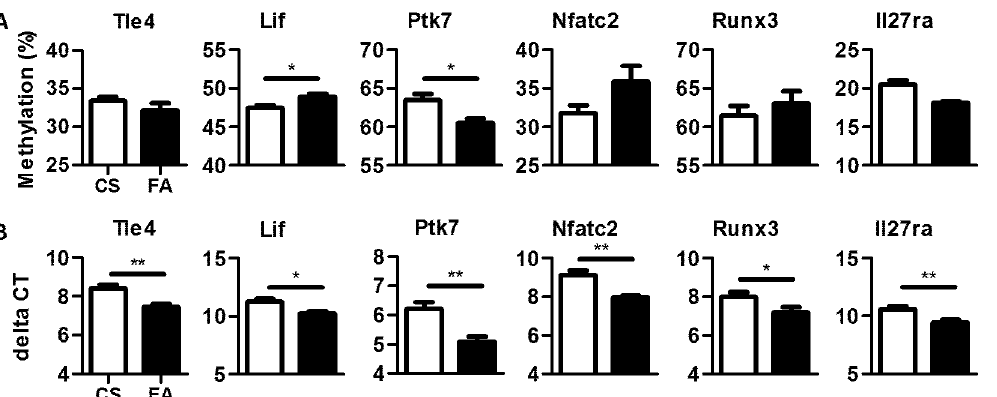
S1 Table. Agilent SureSelect Methyl Sequencing Summary. S2 Table. Suggestive DMRs in HDM-treated CS vs FA